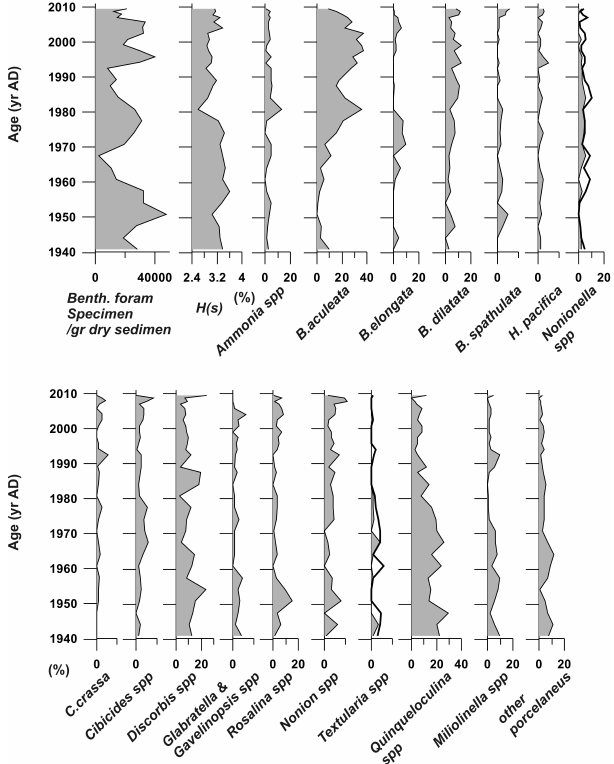
Fig. 3. Downcore changes of benthic foraminifera in per cent (%) of the total benthic foraminifera assemblages in core Amvr15 ver- sus sediment depth together with the indices of benthic productiv- ity (benthic foraminifera specimen/g of dry sediment) and diversity ( H ( s )). Grey bands in the diagrams of Textularia spp. and Non- ionella spp. indicate the relative amounts of T. agglutinans and N. turgida ,